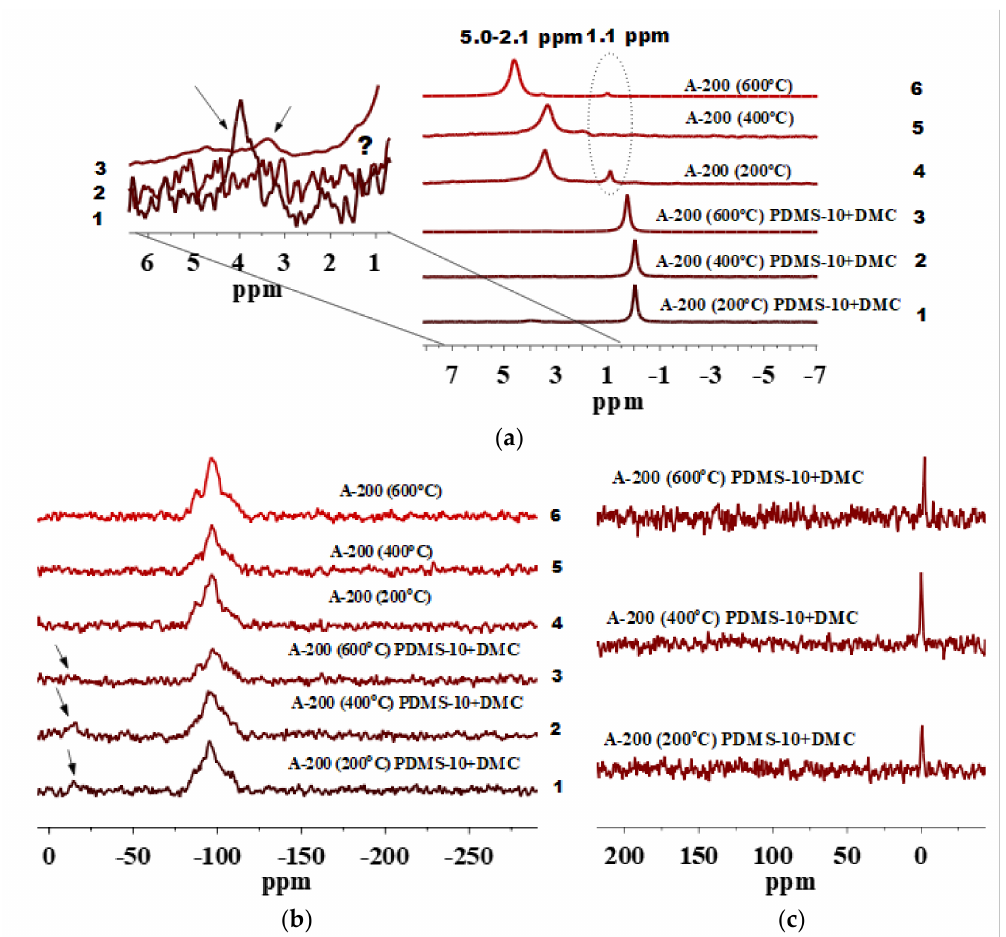
Figure 5. ( a ) 1 H MAS NMR, ( b ) 29 Si CP/MAS NMR, and ( c ) 13 C CP/MAS NMR spectra of fumed silica A-200 preheated at 200, 400, and 600 ◦ C and modified by